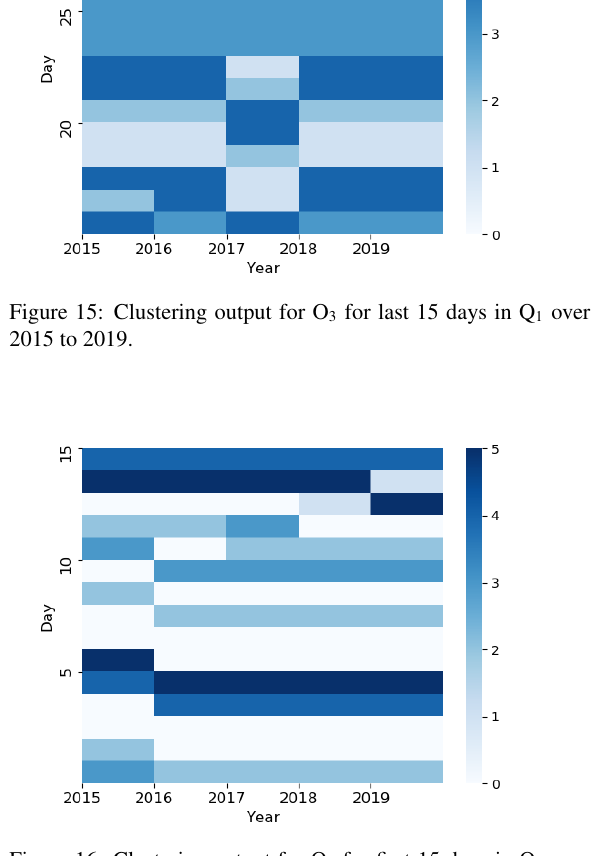
Figure 16: Clustering output for O 3 for first 15 days in Q 2 over 2015 to